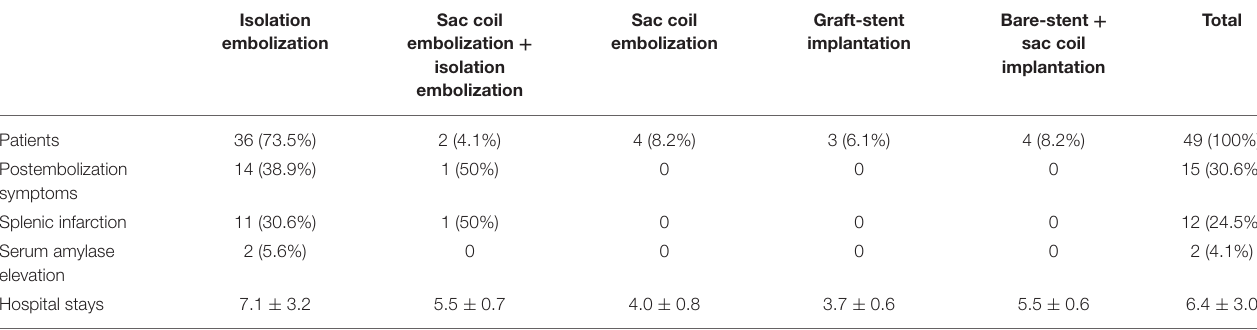
TABLE 2 | Treatment and outcomes of 49 patients with